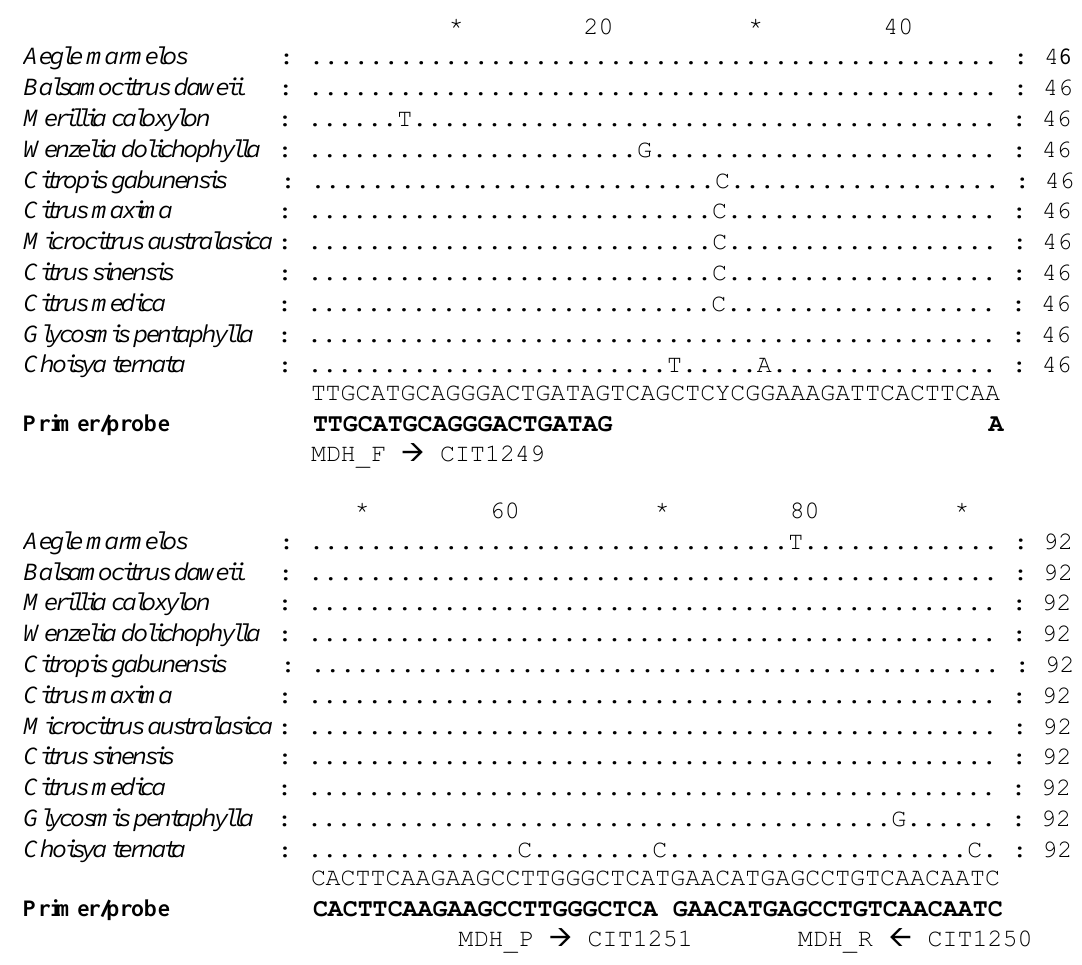
Figure 2. Primers and probe for amplification and detection of a 92 bp gene fragment of MDH reference gene from taxa of the subfamily Aurantioideae. The "*" sign indicates 10 base Table 1. Primers used for conventional, qPCR, and digital PCR detection of various targets. Primers cit637 and cit638 were used for conventional PCR to amplify 900 bp fragments of MDH gene. Other primers and probes were used for qPCR and ddPCR reactions.